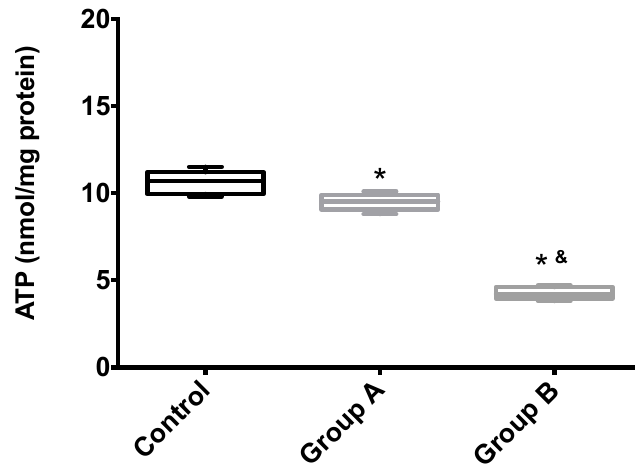
Figure 7. The effects of BBR addition in the preservation solution before ischemia on mitochondrial endogenous ATP content. Mitochondria were isolated from animals sacrificed after 12 h of hepatic exposure to preservation solution and 1 h of reperfusion, as described in the Materials and Methods Section. Control animals were sham operated. ATP content was evaluated with a fluorescent kit, as described in the Materials and Methods Section. As expected, mitochondria isolated from the animals from the I/R livers (Group B) had a significant reduction in endogenous ATP levels when compared with both the control and BBR-supplemented I/R (A) groups. Boxes represent the means ± 5–95 percentile of an n = 4 different experiments. * indicates a statistically-significant difference ( p < 0.05) against the control group; & indicates a statistically-significant difference ( p < 0.05) against Group A.